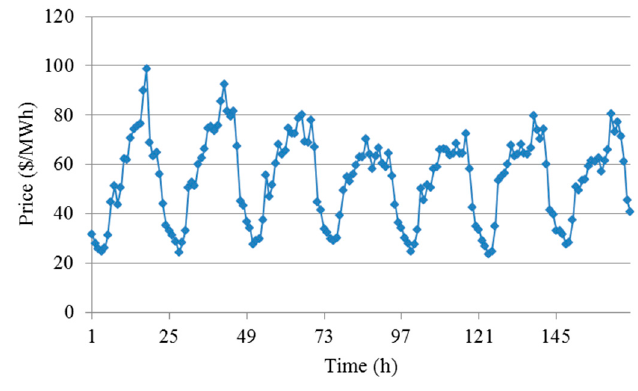
Figure 2. Estimated electricity price data for 168 hours ($/MWh).